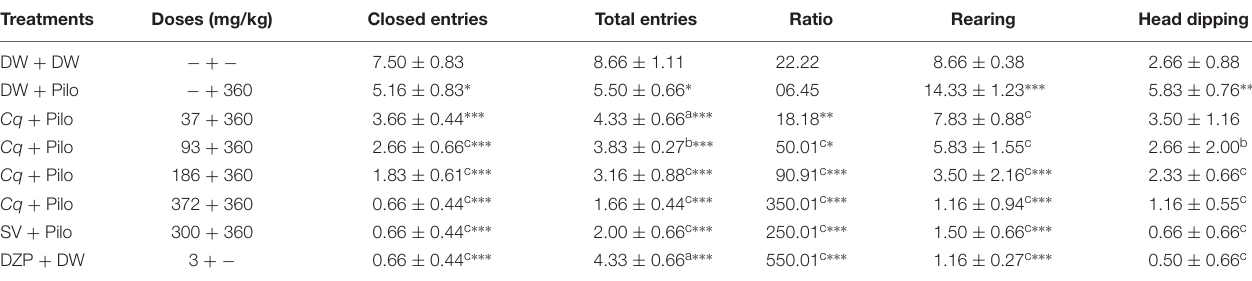
TABLE 1 | Effect of C. quadrangularis in EPM test: closed arm entries, total arms entries, ratio OE/TE vs CE/TE, rearing, and head dipping. Treatments Doses (mg/kg) Closed entries